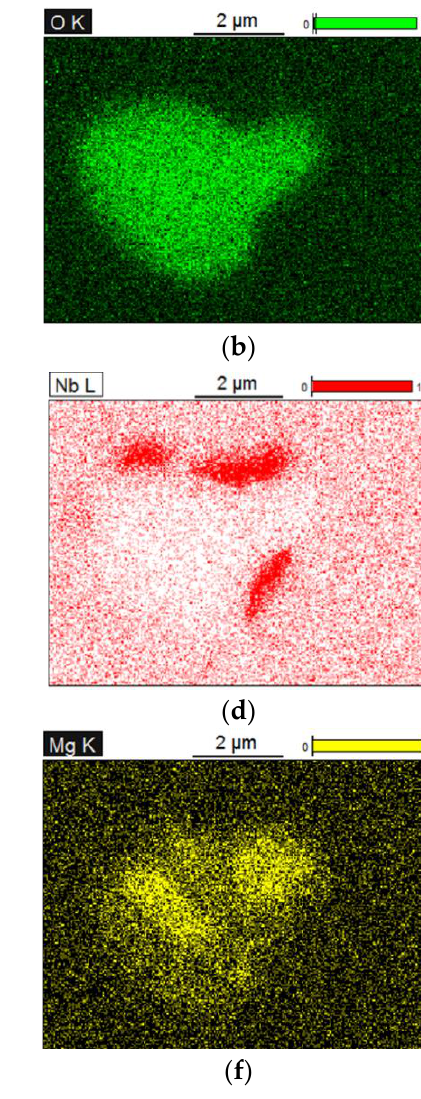
Figure 7. EDS mapping of Al 2 O 3 at micron scale; ( a ) SEM image; ( b ) O; ( c ) Al; ( d ) Nb; ( e ) Ti; ( f )